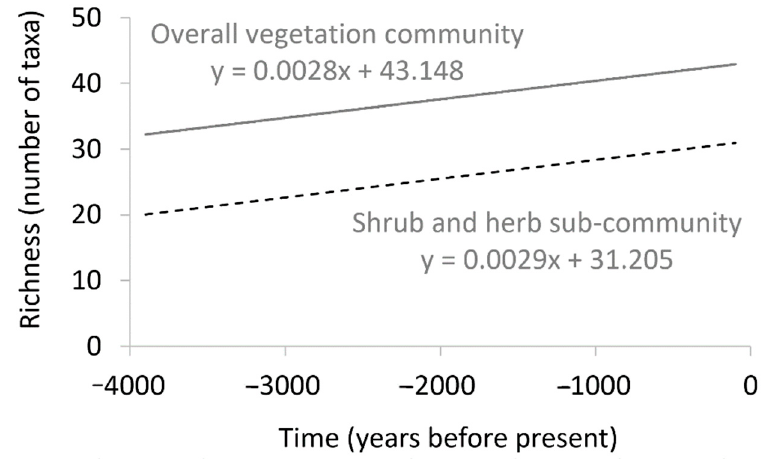
Figure 3. Schematic of the relationship between taxonomic richness in the overall vegetation com- munity (solid line) and the shrub and herb sub-community (dashed line) at 23 sites in western Eurasia in relation to time. The equations were calculated using regression analysis on raw data (n = 867 for overall vegetation community and 866 for shrub and herb sub-community) and values show the change in richness per 100 years.